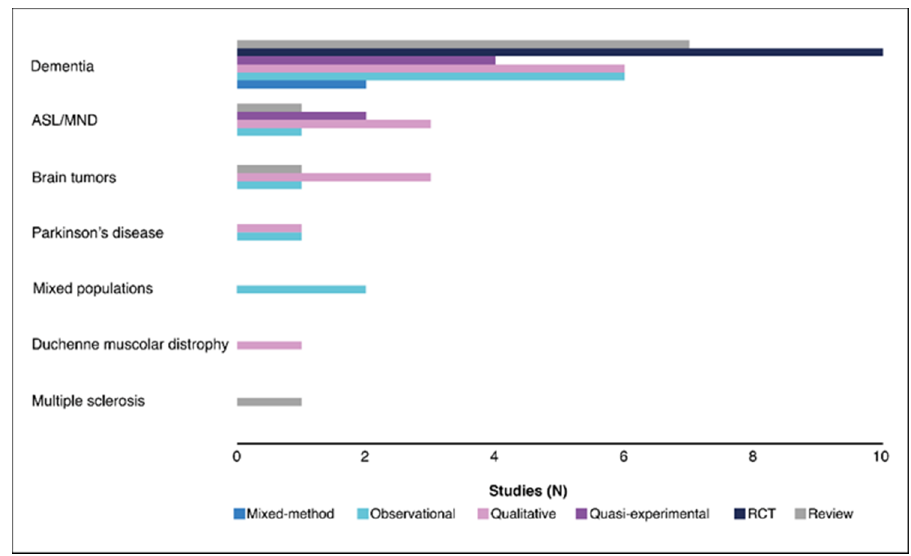
Figure 1. Number of studies by disease and by study design. ALS is amyotrophic lateral sclerosis; MND is motor neuron disease; RCT is randomized controlled trial.